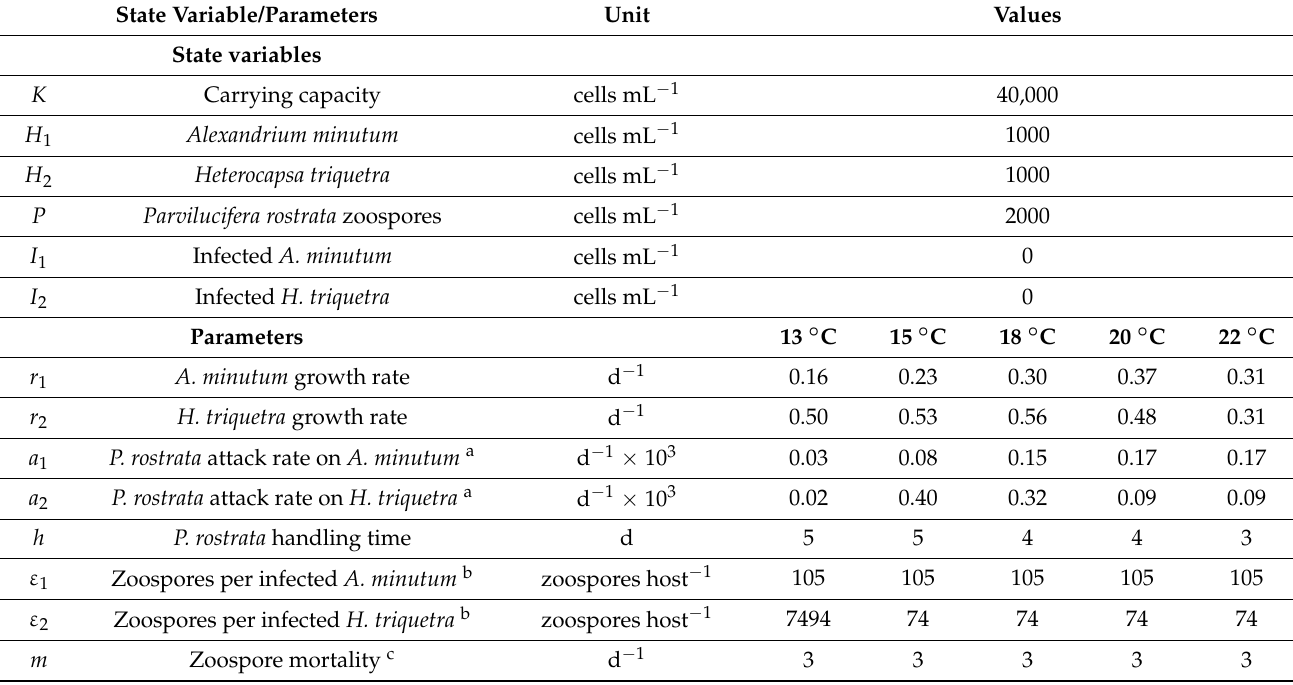
Table 1. Values of the parameters and state variables considered in the numerical